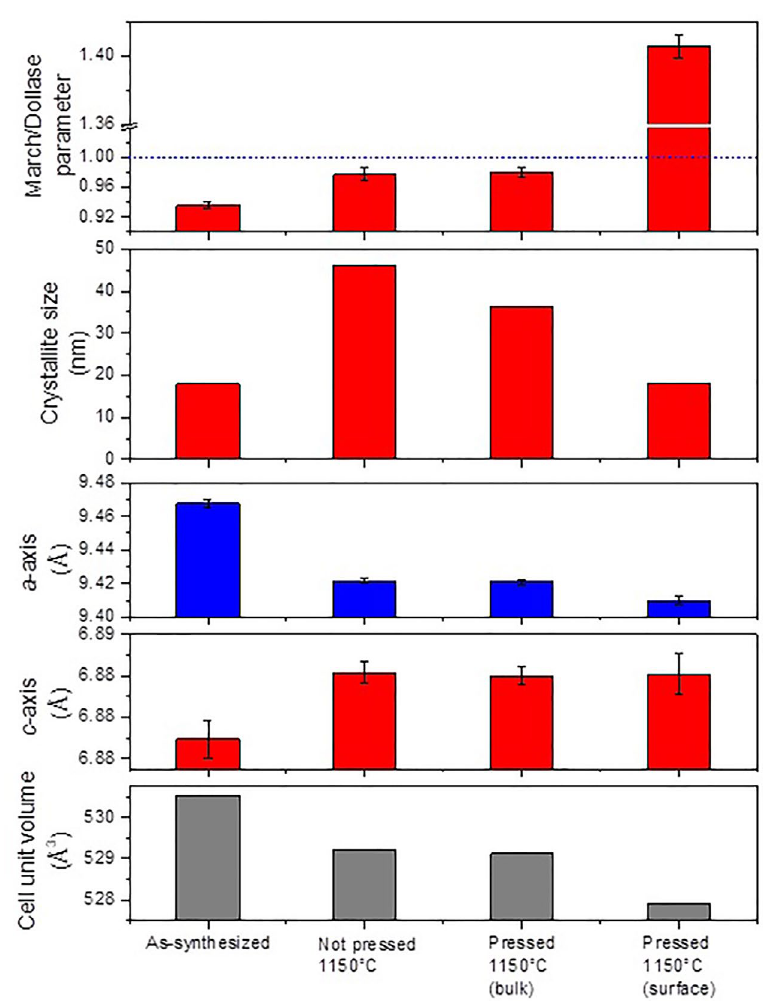
Figure 3. Lattice parameters, cell unit volume, crystallite size and orientation of the hydroxyapatite crystals throughout processing, as measured from Rietveld refinement data.